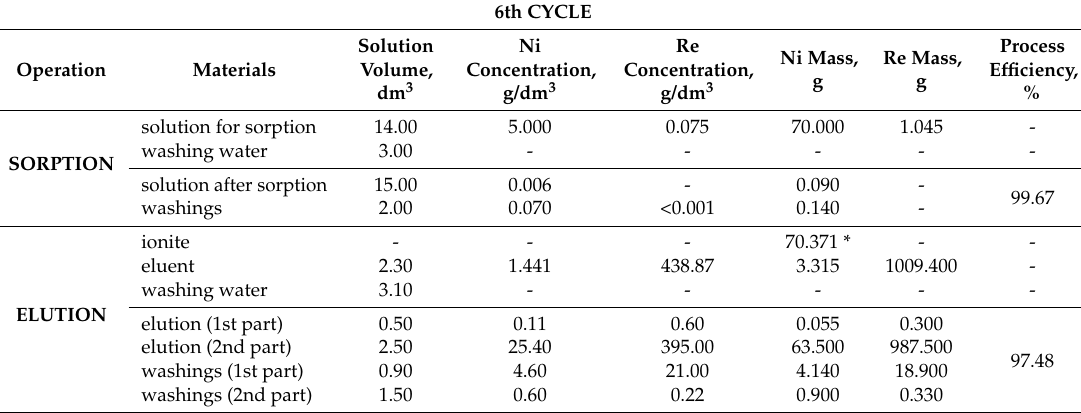
Table 20. Balance for nickel(II) sorption and elution—6th cycle. 6th